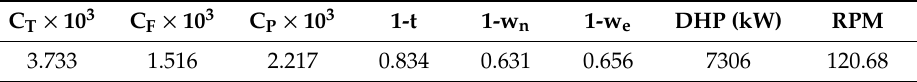
Table 9. Calculated propulsive characteristics at ship scale.